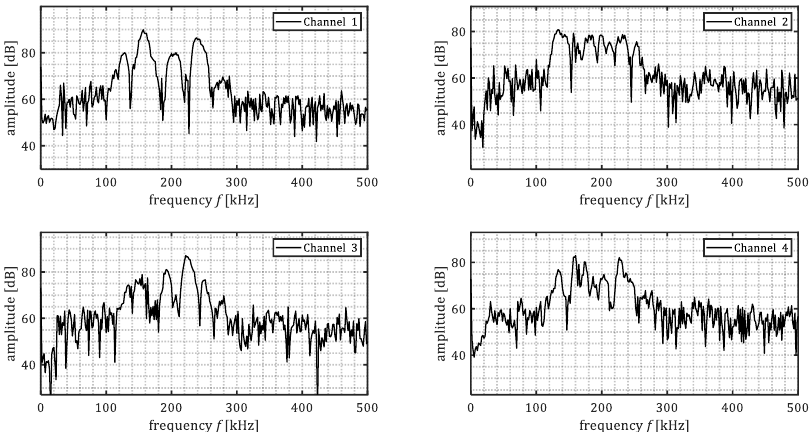
Figure 11. Frequency content of one corrosion event (baseplate).